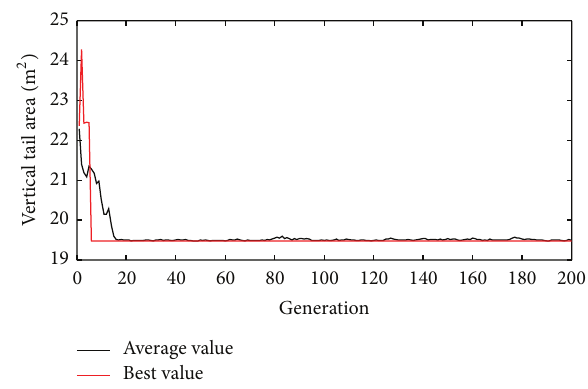
Figure 8: Best and average vertical tail area (m 2 ) versus